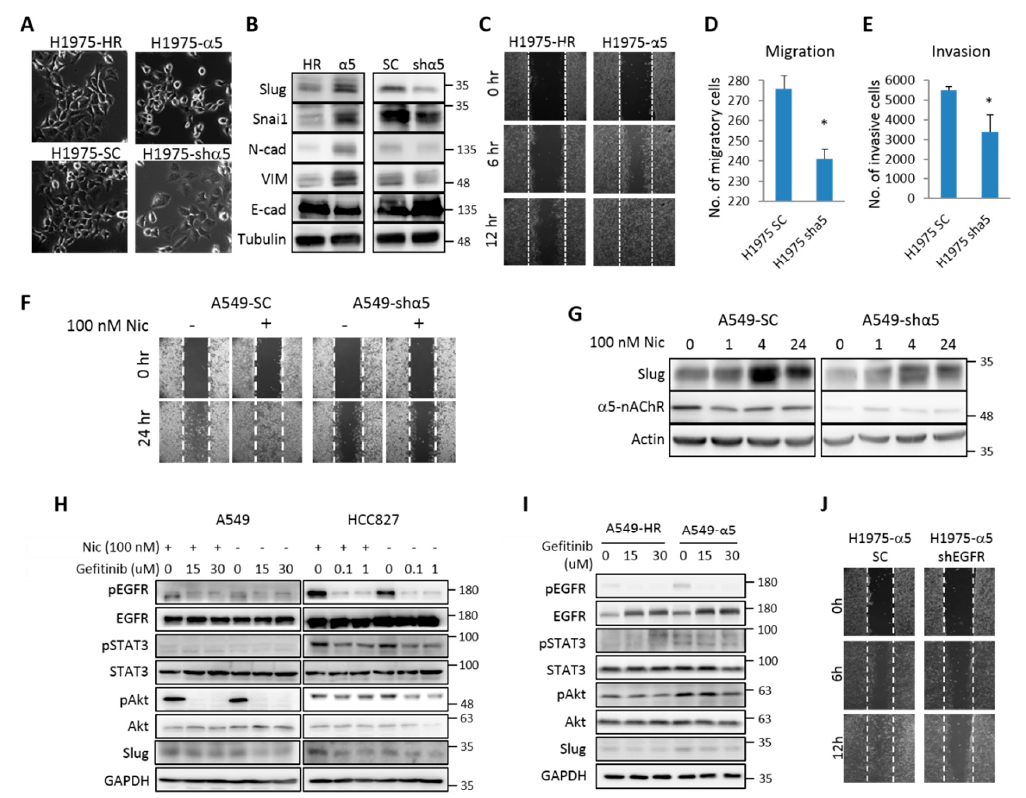
Figure 4. α 5-nAChR is essential for low-dose nicotine-induced cell motility. ( A ). Micrographs showing the morphological changes induced by α 5-nAChR overexpression or knockdown in H1975 cells. ( B ) H1975 stable cells were subjected to an analysis of EMT(epithelial-mesenchymal transition)-related protein expression by western blot. ( C ) Control (H1975-HR) and α 5-nAChR-overexpressing (H1975- α 5) cells were subjected to the wound-healing mobility assay for up to 12 h. ( D , E ) Control (H1975-SC) and α 5-nAChR-knockdown (H1975-sh α 5) cells were subjected to Transwell assays for migration ( D ) and invasion ( E ) for 24 h. Numbers of migratory and invasive cells were quantified. Statistical analysis was performed using unpaired Student’s t test. * p < 0.05. ( F ) Control (A549-SC) and α 5-nAChR-knockdown (A549-sh α 5) cells were subjected to a wound-healing mobility assay in the presence or absence of 100 nM nicotine for 24 h. ( G ) Control (A549-SC) and α 5-nAChR-knockdown (A549-sh α 5) cells were serum-starved for 8 h, treated with 100 nM nicotine for indicated time, and analyzed by western blotting. ( H ) A549 and HCC827 cells were treated with Gefitinib at indicated concentrations 30 min before nicotine (100 nM) or vehicle treatment for another hour. Lysates were analyzed by western blotting for expression levels and phosphorylation status of indicated proteins. ( I ) A549 stable clones were treated with Gefitinib and subjected to western blot analysis as in ( H ). ( J ) EGFR-knockdown and control cells were established from α 5-nAChR-overexpressing (H1975- α 5) stable clone. Cells were subjected to a wound healing migration assay for up to 12 h. All data were repeated in at least three independent experiments to achieve statistical significance. The numbers at the right-hand side of the western blots indicates the sizes of the nearest protein markers.